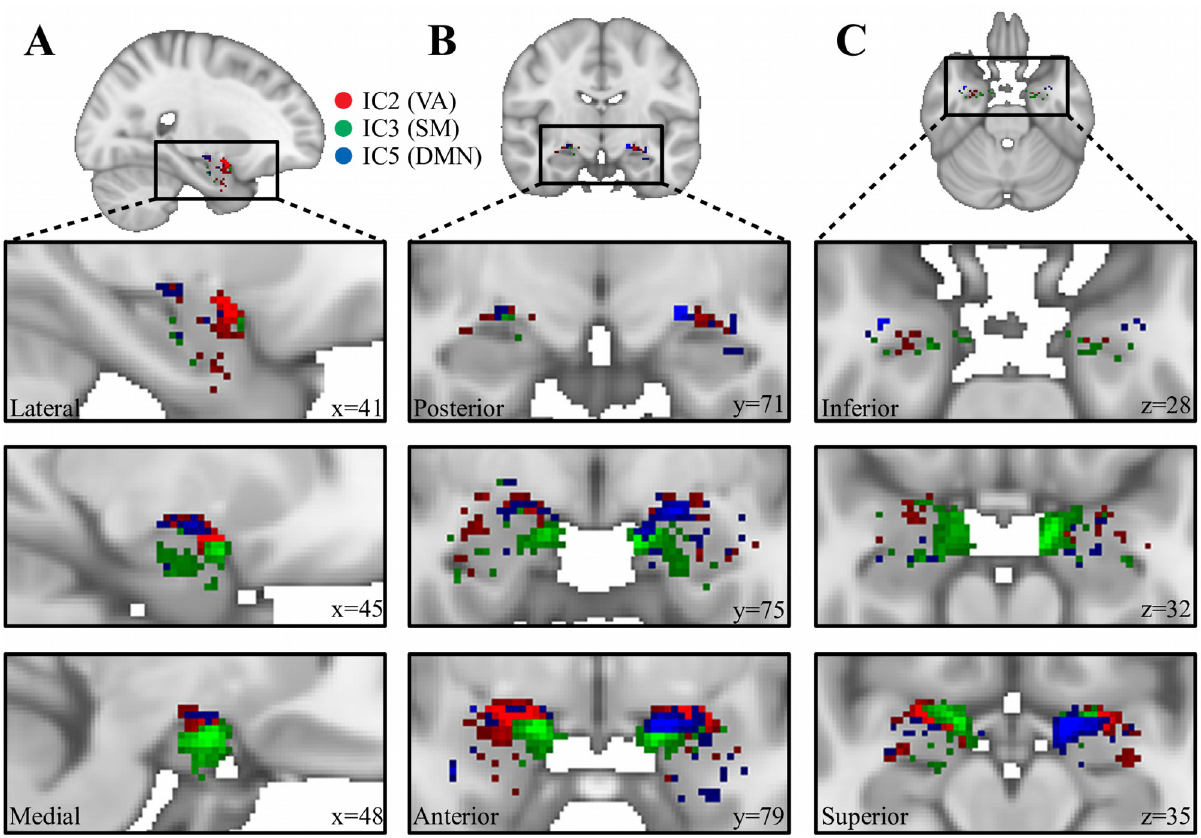
Fig 4. Detailed view of results from srICA. C2 (red, associated with Ventral Attention), IC3 (green, associated with Somatomotor) and IC5 (blue, associated with Default Mode) in saggital (A), coronal (B), and axial (C)